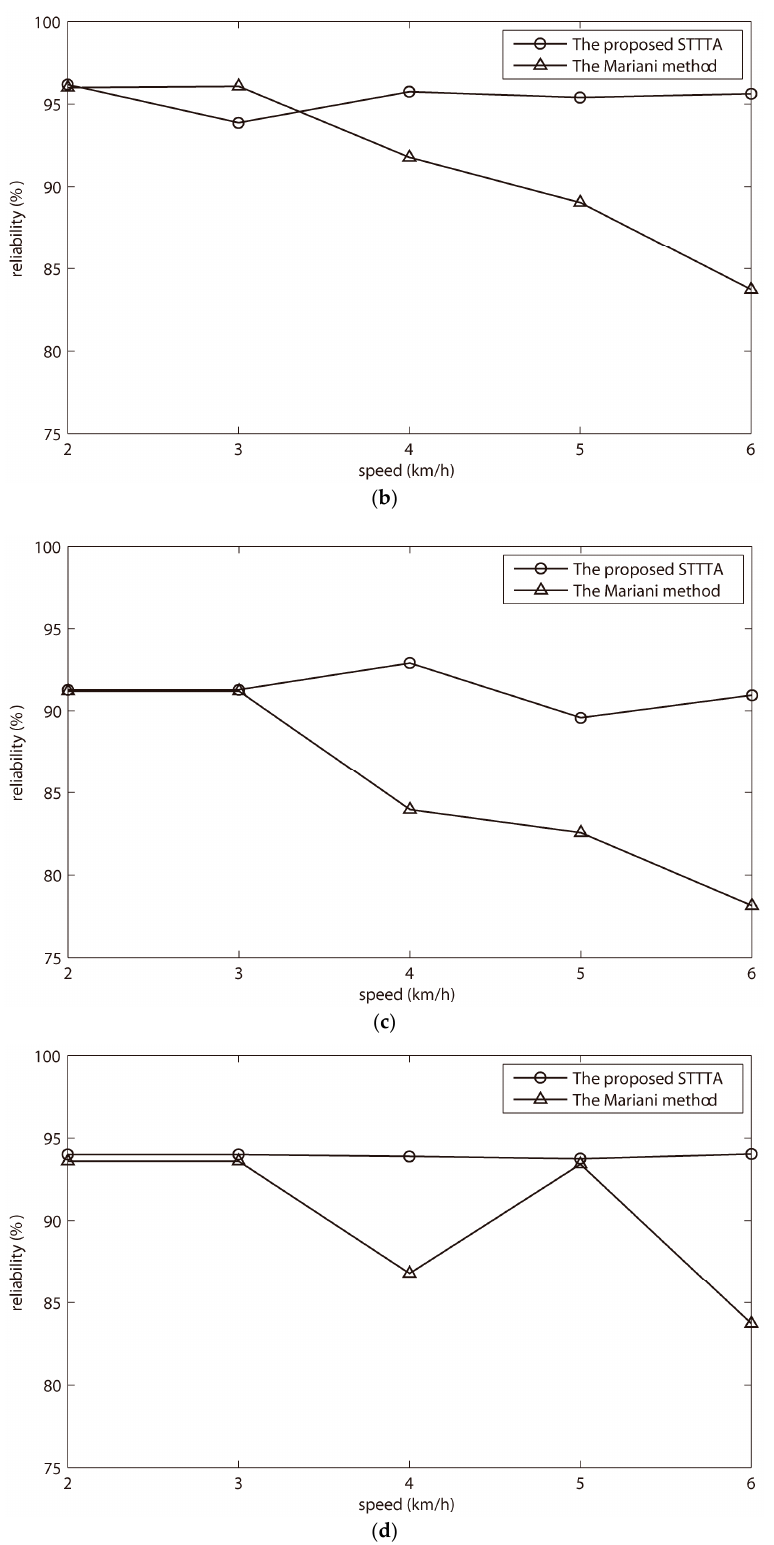
Figure 5. Reliabilities of the Mariani and STTTA method for one male subject at five walking speeds: ( a ) TAM method as reference method; ( b ) Lopez–Meyer method as reference method. Reliabilities of the Mariani and STTTA method for one female subject at five walking speeds; ( c ) TAM method as reference method; ( d ) Lopez–Meyer method as reference method.